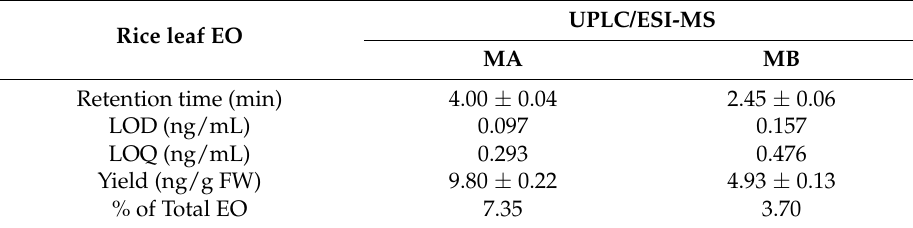
Table 4. Identification and quantification of momilactones A and B from rice leaf EO by UPLC/ESI-MS. UPLC/ESI-MS Rice leaf EO MA MB Retention time (min) 4.00 ±